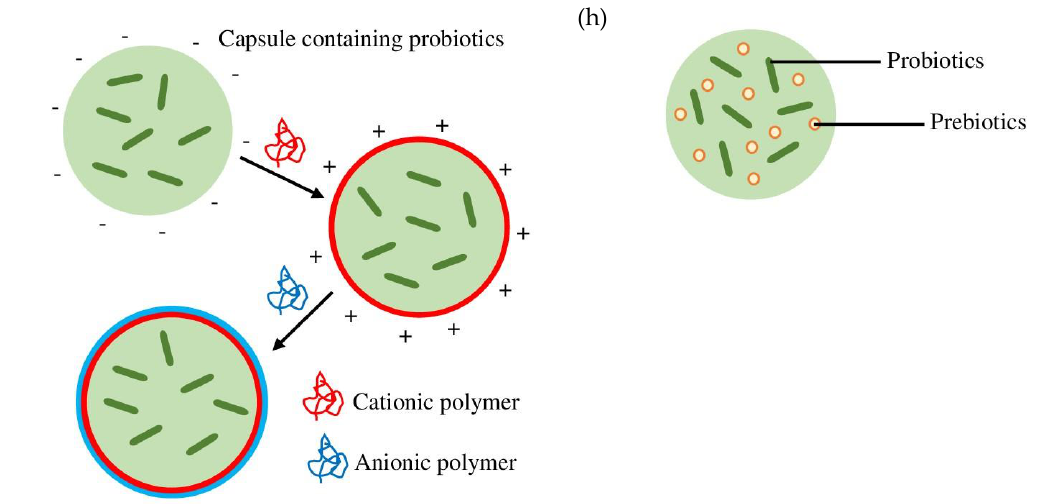
Figure 1. Different types of probiotics encapsulation techniques and the morphologies of corresponding microcapsules obtained: ( a ) ionic gelation (emulsion, extrusion); ( b ) coacervation; ( c ) fluidized bed coating; ( d ) freeze-drying; ( e ) spray-drying; ( f ) spray chilling; ( g ) layer-by-layer method; ( h ) co-encapsulation.